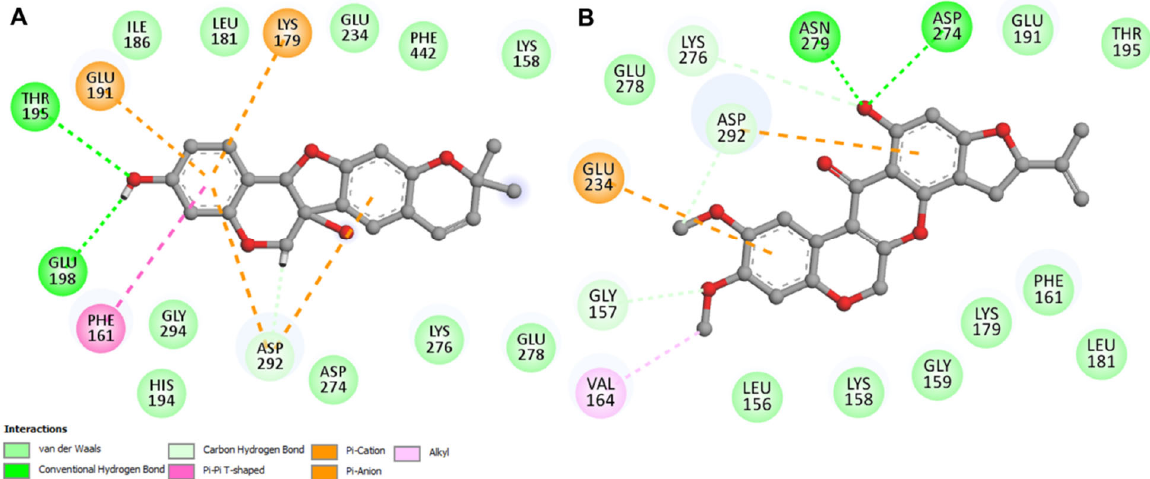
Figure 2. The two-dimensional representation of binding pocket residues of AKT1 and its respective interactions with compounds tuberosin ( A ) and villosol ( B ). The tuberosin shows the noncovalent interactions formed between the active site and ATP-binding residues of protein AKT1. The hydrogen bonds are formed between sites Lys179, Glu191, and Asp 292. The villosol shows noncovalent interactions between crucial residues of protein Glu234 and Asp292, with target protein AKT1.